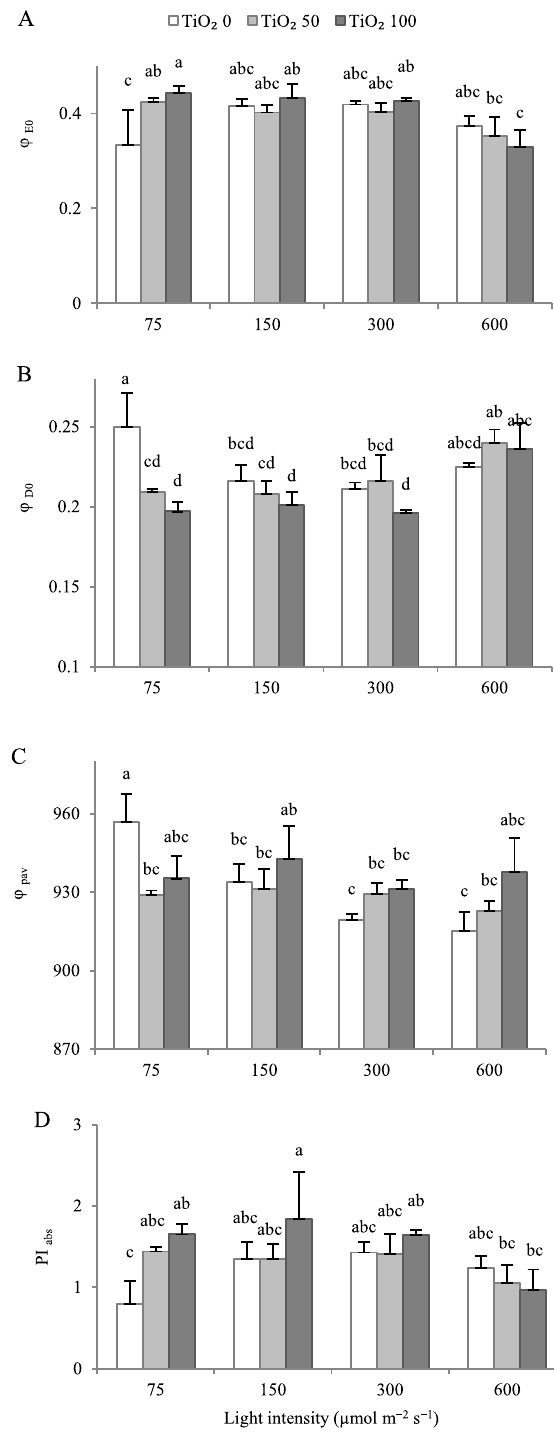
Figure 8. Effect of cultivation light intensity (75, 150, 300 and 600 µmol m −2 s −1 ) and spray treatment (once a week, and three times in total) with titanium dioxide (TiO 2 ) nanoparticles (open, grey, and dark grey for 0, 50 and 100 µmol L −1 , respectively) on quantum yield of electron transport (φ E0 ; A ), quantum yield of energy dissipation (φ D0 ; B ), quantum yield for primary photochemistry (φ PAV ; C ), performance index in light absorption basis (PI ABS ; D ) (equations and explanations in Table 3) of radish cv. Cherry belle plants. Nine replicate plants were assessed per treatment. Bars represent SEM. In traits, where the interaction of the two factors (light intensity, TiO 2 nanoparticle level) was significant, different letters indicate significant